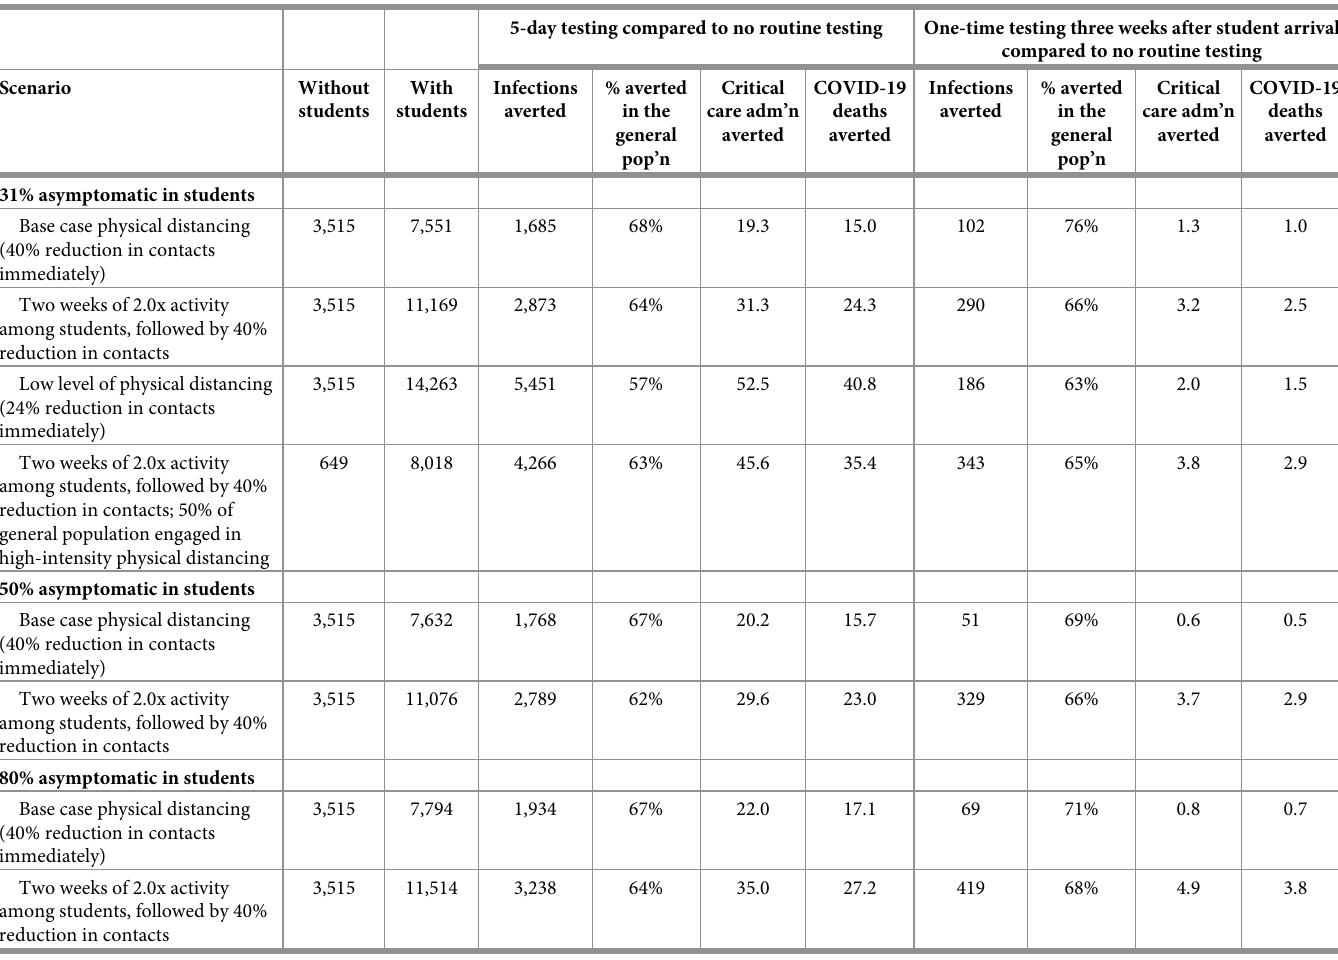
Because the current cost of a nasopharyngeal COVID-19 test is $80 at our center, high-fre- quency testing may be cost-prohibitive. Alternatively, one-time universal testing of students Table 2. Infections averted in the general population with 5-day testing and one-time testing of students compared to a policy of no routine asymptomatic testing (symptom-based surveillance and contact tracing only). 5-day testing compared to no routine testing One-time testing three weeks after student arrival compared to no routine